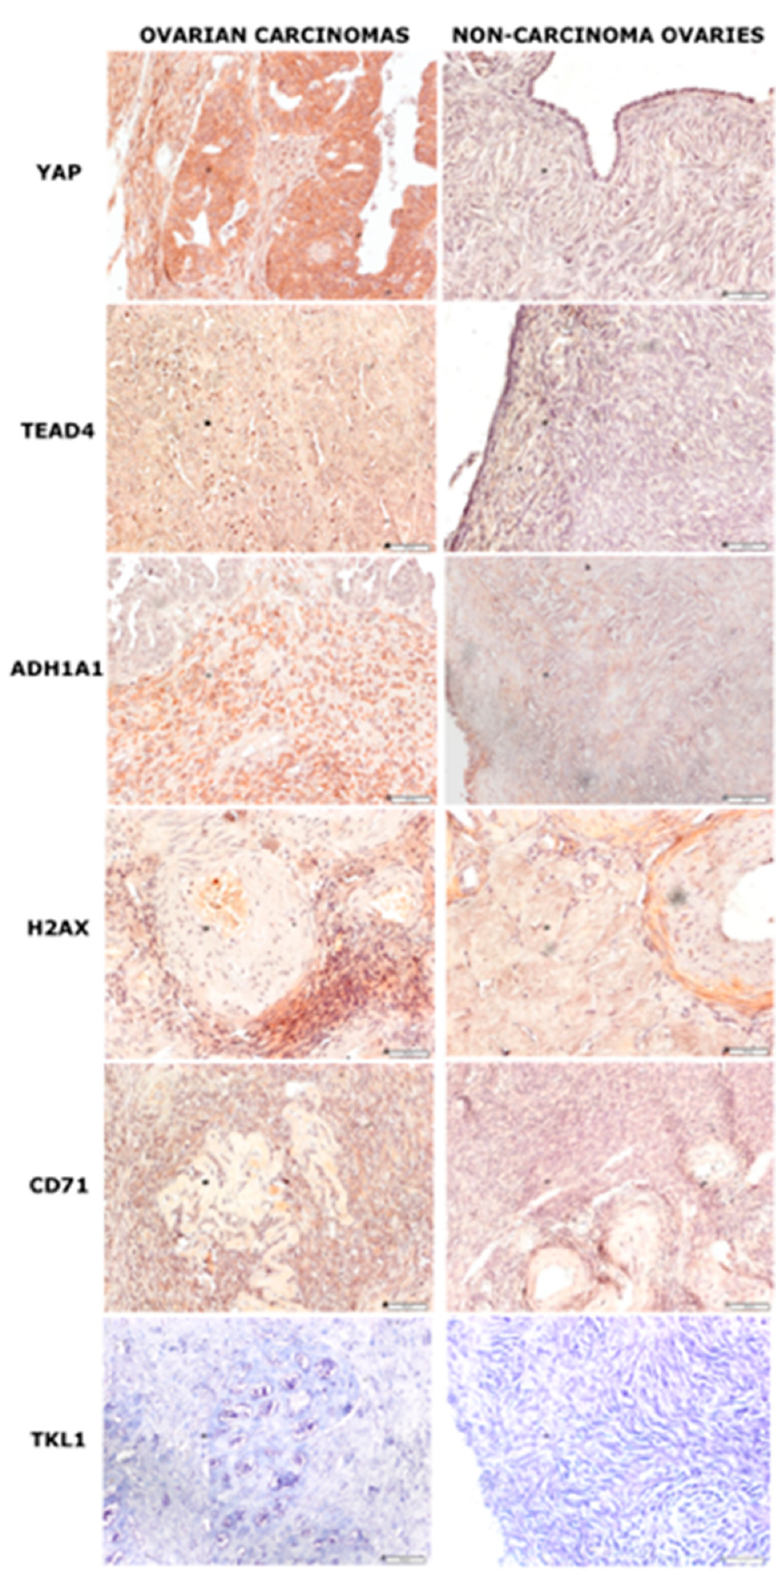
Figure 2. Immunohistochemical staining in ovarian carcinoma and non-carcinoma ovarian samples. Magnification: 20 × , scale bar: 50 µ